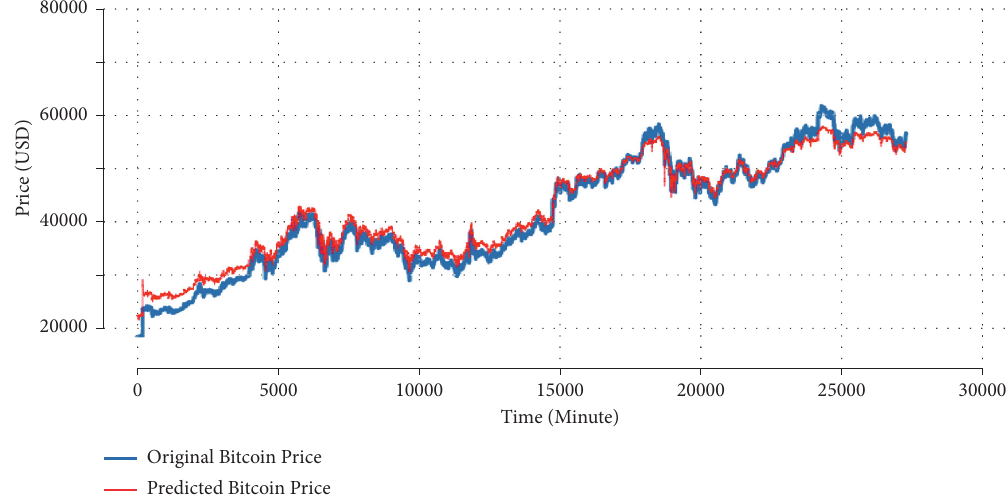
Figure 11: Prediction results via SVR-rVMF model.